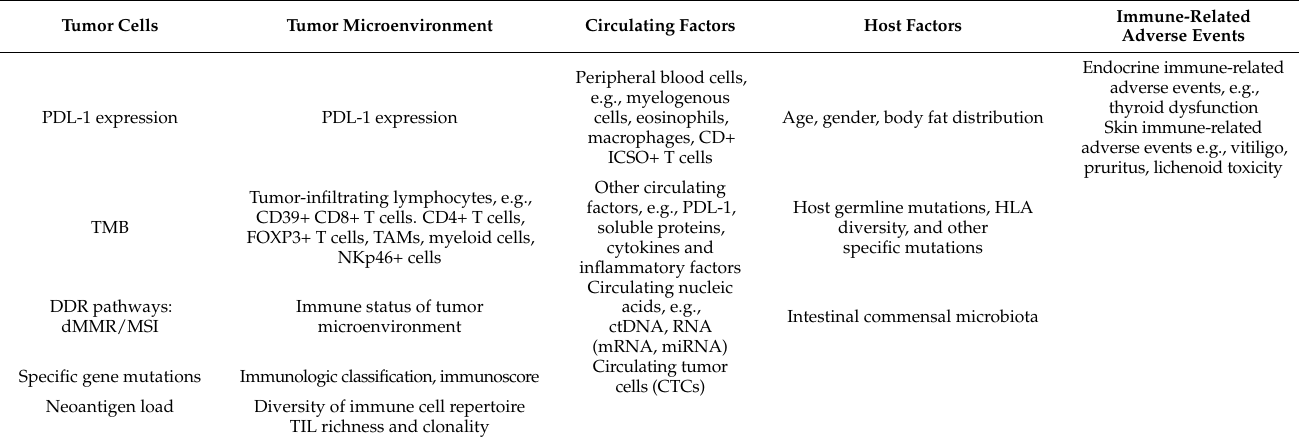
Table 1. A general representation of predictive biomarkers of response to immune checkpoint inhibitors.